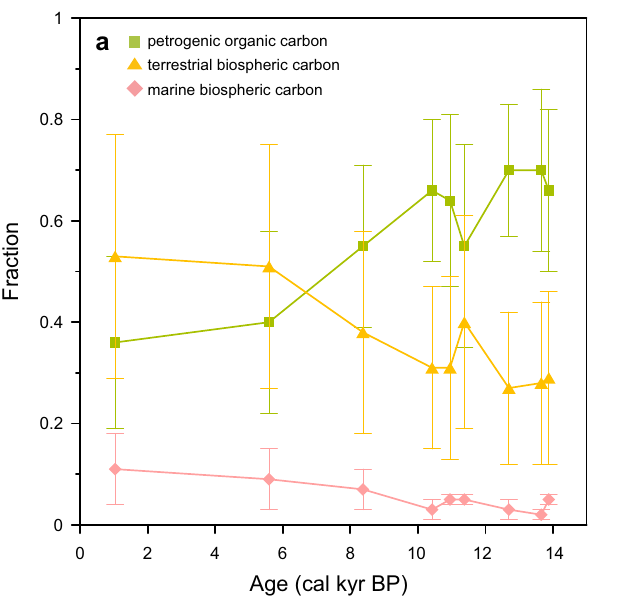
Fig. 4 | Dual-isotope mixing model and source apportionments.a OC fractions fromdifferent carbonsources.Error barsrepresentstandarddeviation; b δ 13 Cand F 14 C values of measured samples (red dots) and of endmembers for marine